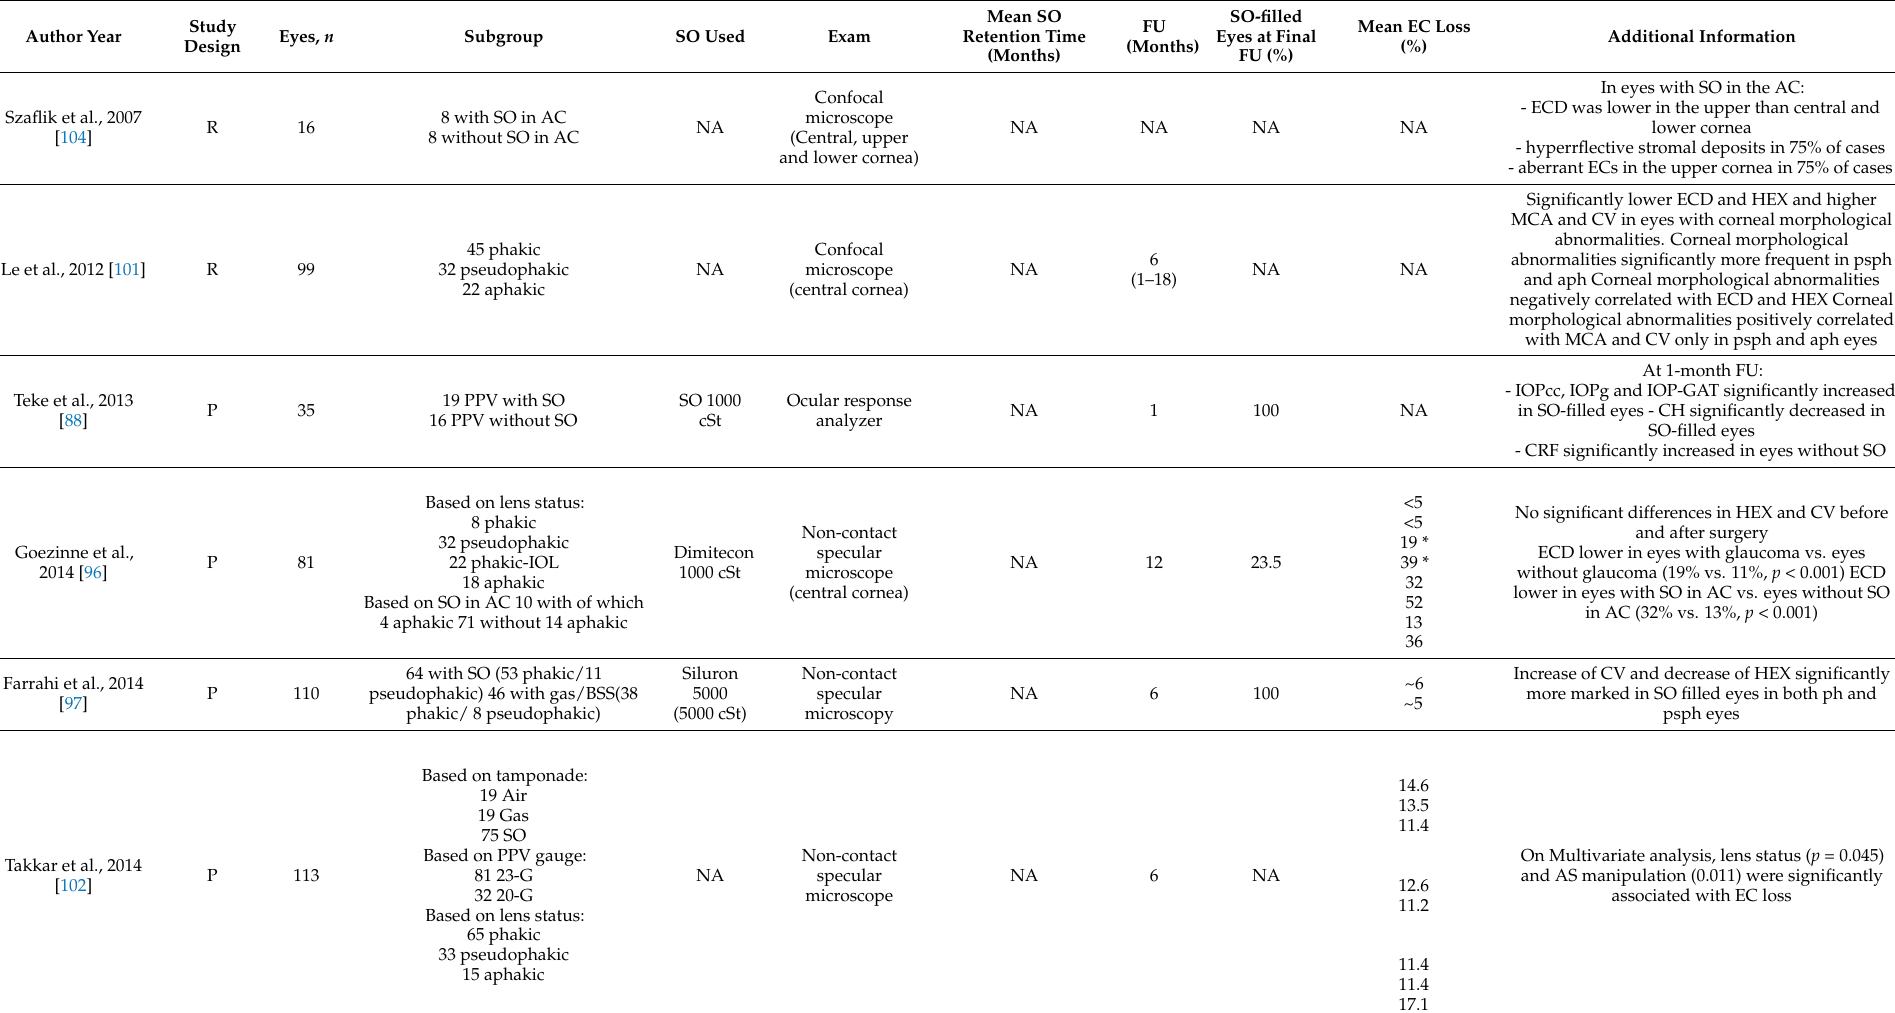
Table 2. Corneal changes associated with silicone